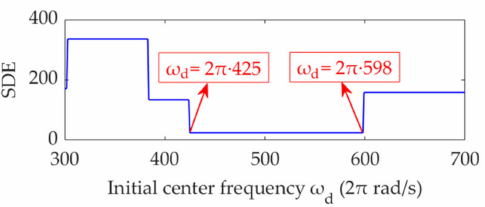
Figure 5. Relationship between the initial center frequency, ω d , and SDE